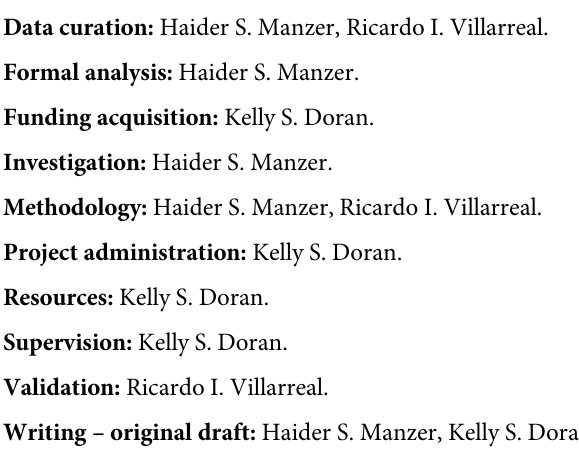
S1 Table. Specific genes used for molecular serotyping. S2 Table. Primers used in this